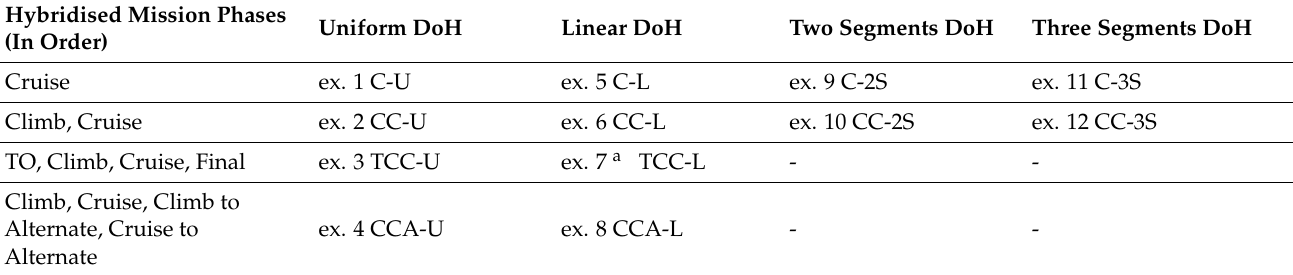
Table 5. Definition of Experiments.